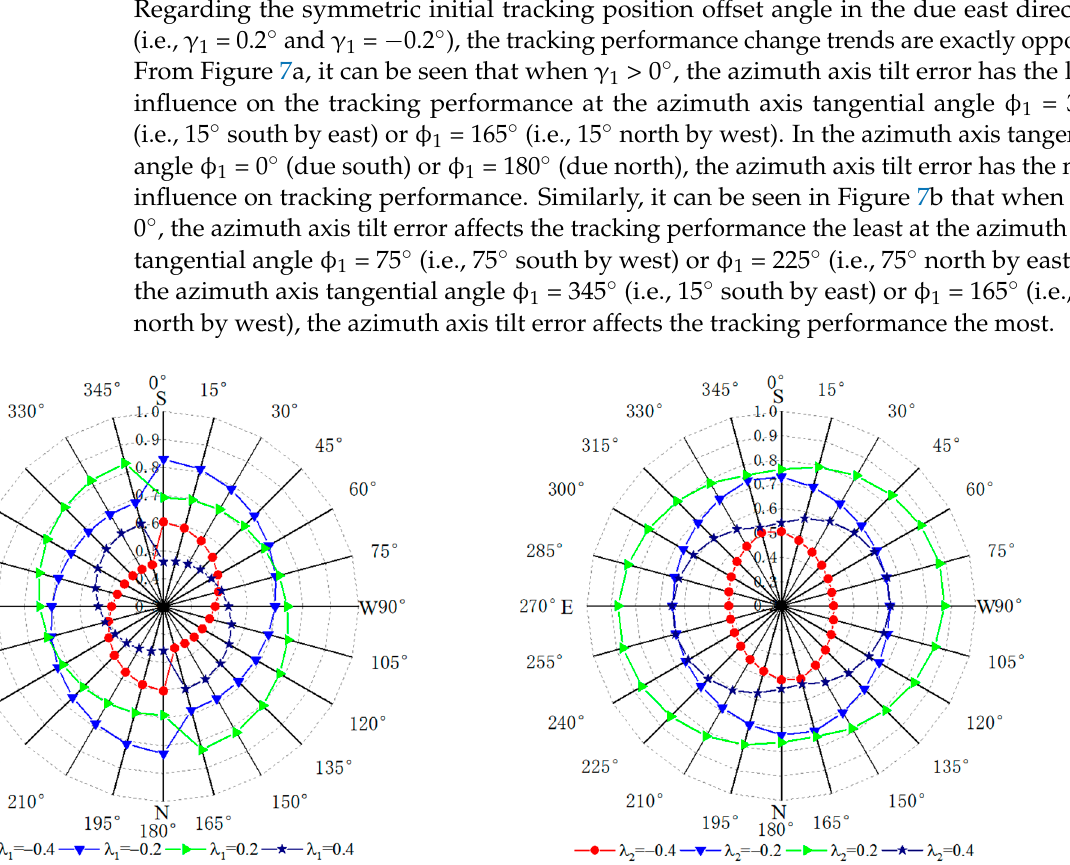
Figure 8. Variation of the daily average effective tracking factor σ initial tracking position offset.